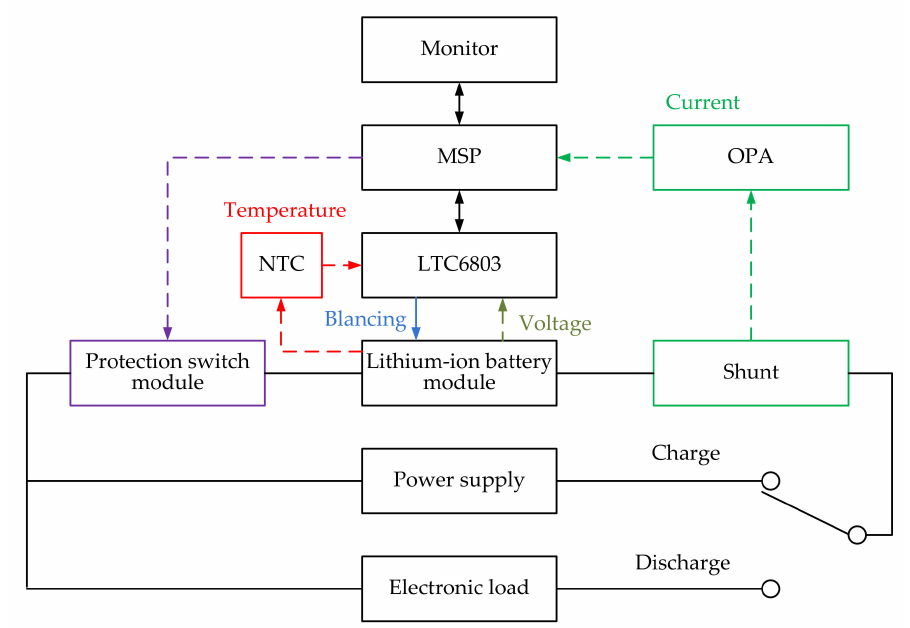
Figure 1. The system structure of the modular battery management